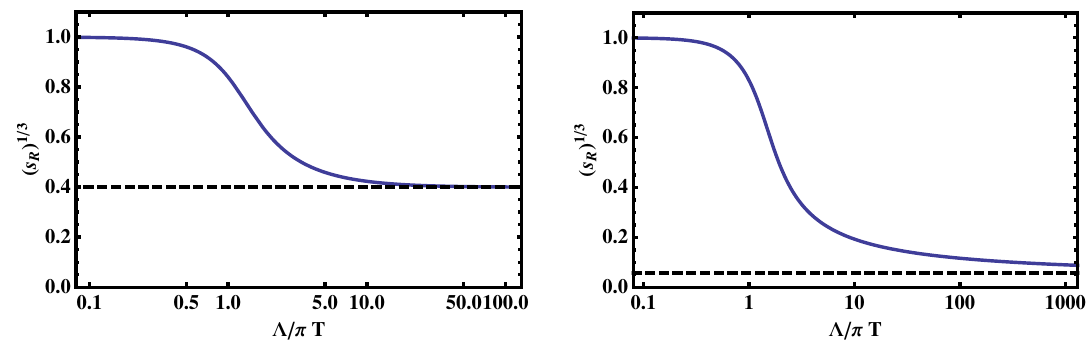
Figure 1 . Ratio of entropy density to temperature for (cid:30) function of the inverse temperature. The dashed line shows L